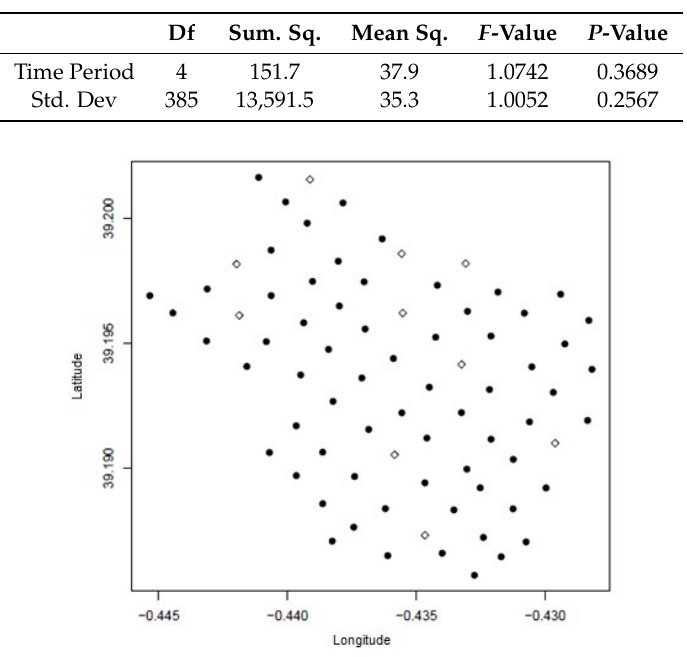
Table 3. ANOVA (Analysis of Variance) of noise levels in different time periods.